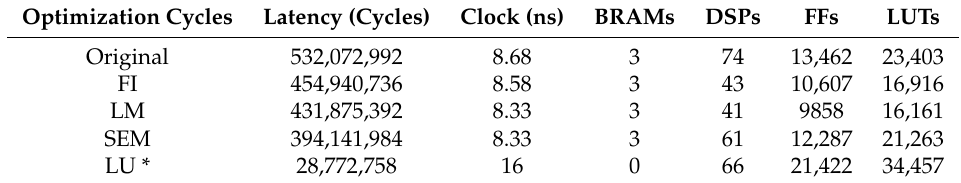
Table 3. Optimization evaluation: “ * ” indicates the proposed implementation. LM, Loop Manipulation; LU, Loop Unwinding. Optimization Cycles Latency (Cycles) Clock (ns) BRAMs